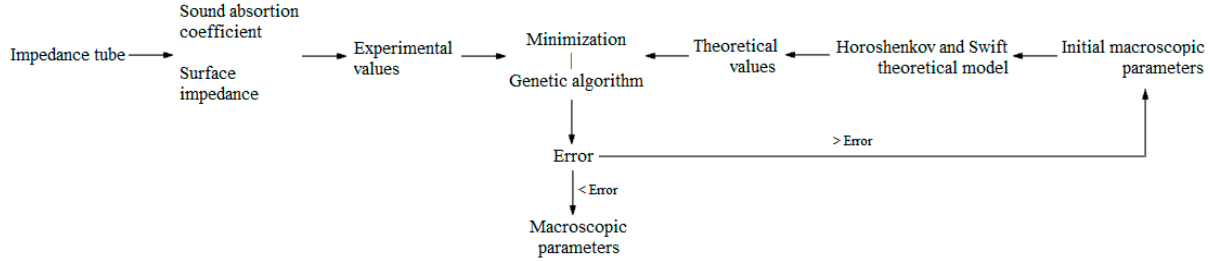
Figure 8. Flowchart of the inversion methodology used to compute the macroscopic parameters.